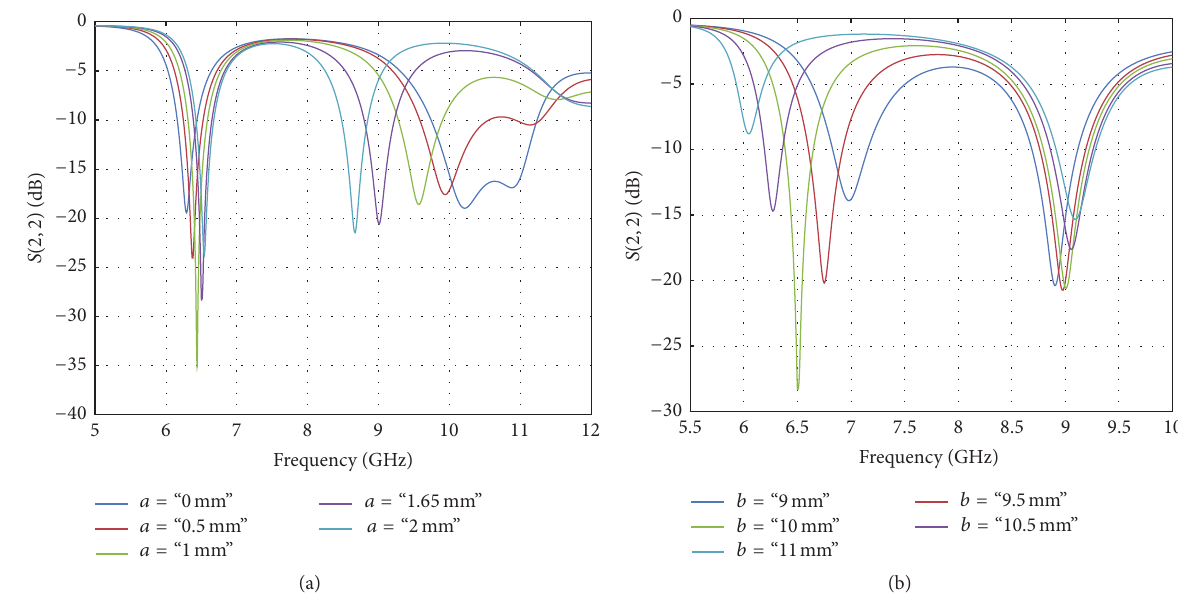
Figure 18: Reflection coefficients of the first NB antenna for (a) slot length variations and (b) microstrip stub length